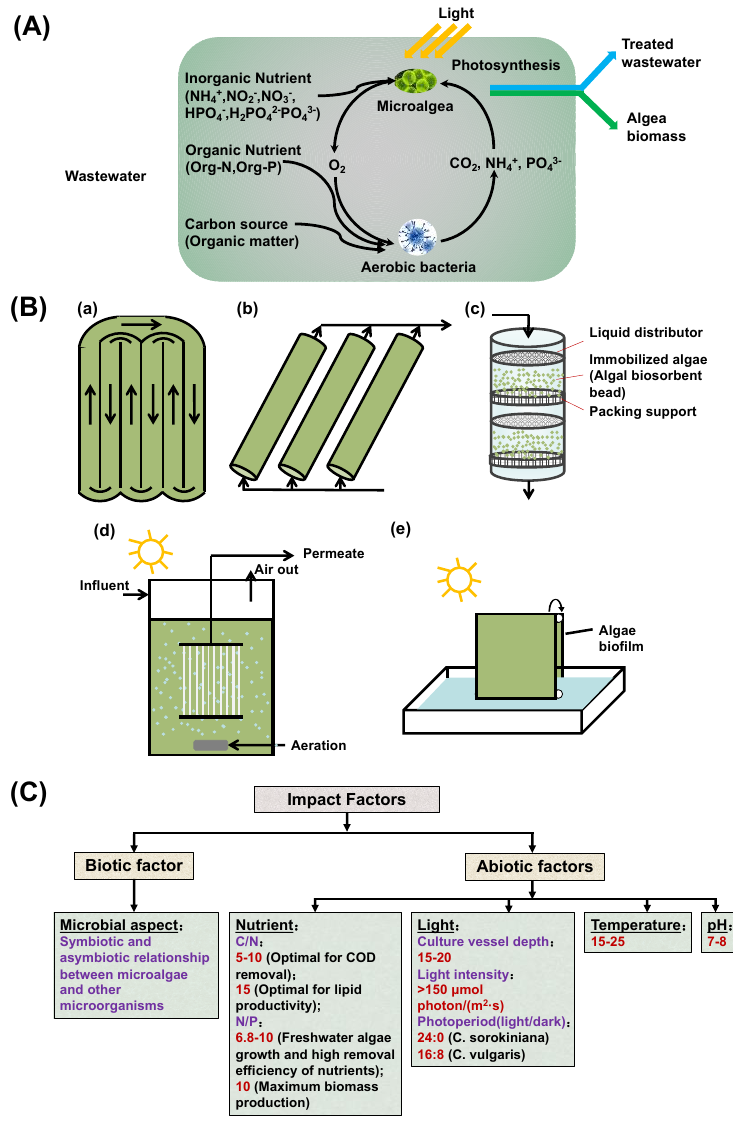
Figure 2. MA-based wastewater treatment: ( A ) Schematic nutrient uptake mechanism of the MA- bacteria system from wastewater; ( B ) Schematic diagrams of different photobioreactors (( a )